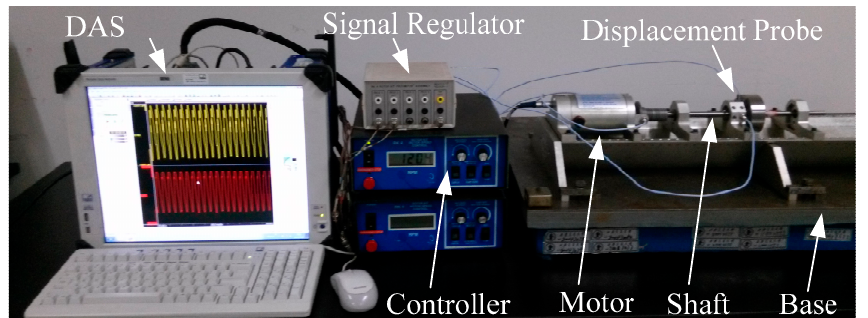
Appl. Sci. 2019 , 9 , x FOR PEER REVIEW Figure 6. Bently KR4 Rotor Test Rig and data acquisition system. Figure 6. Bently KR4 Rotor Test Rig and data acquisition system.